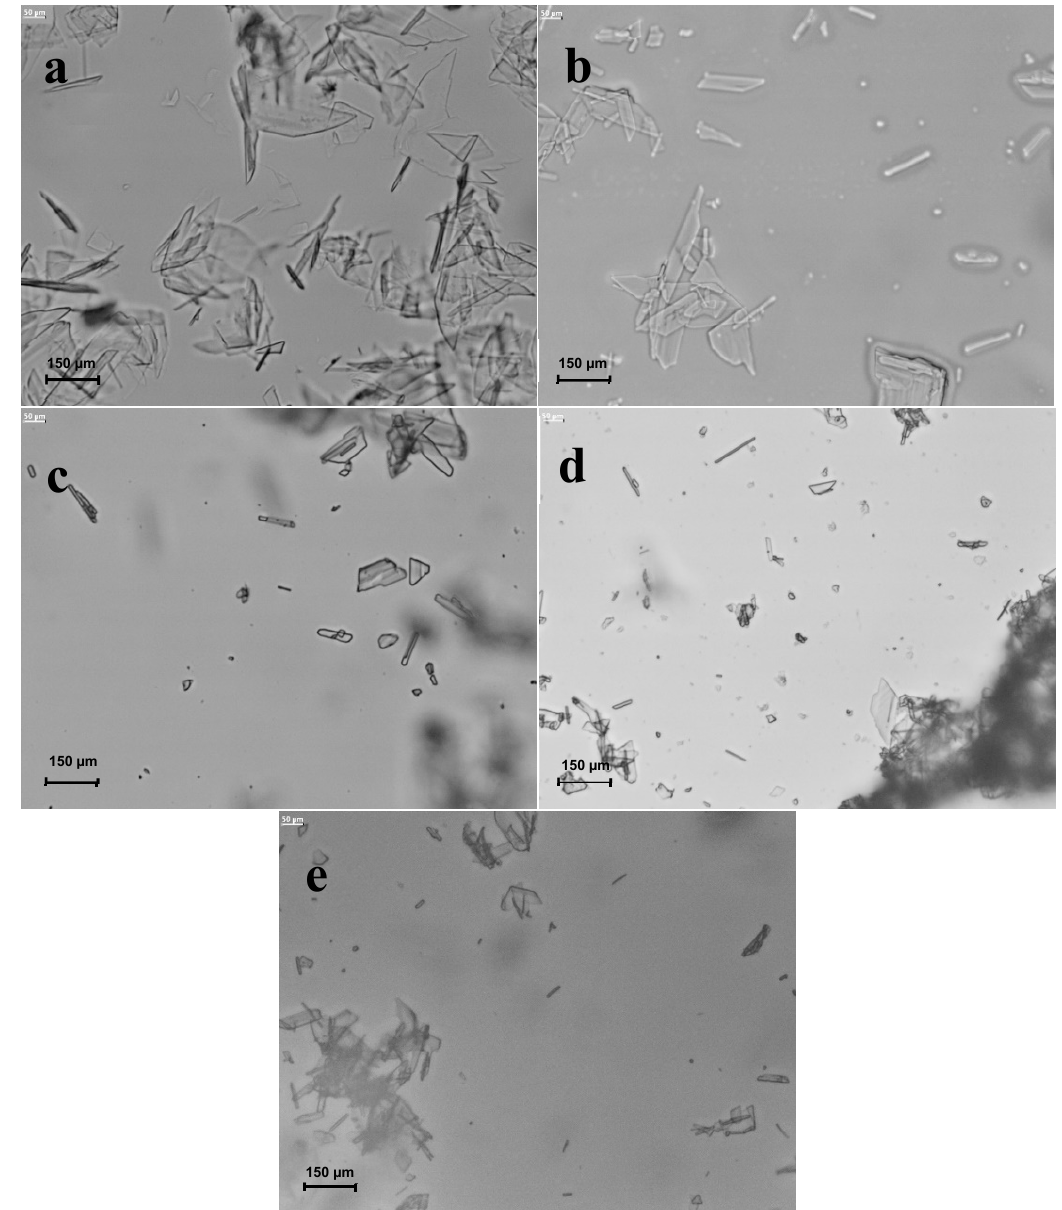
Figure 8. Microscopic photographs (magnification 50 × ) of obtained calcium sulfate dihydrate for T = 298 K, n = 1.67 s − 1 and various concentration: ( a ) C = 0.15 M; ( b ) C = 0.20 M; ( c ) C = 0.25 M; ( d ) C = 0.30 M; ( e ) C = 035 M.